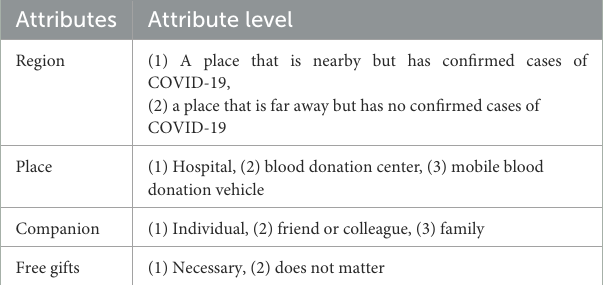
TABLE 4 Attributes and attribute levels of the blood donation